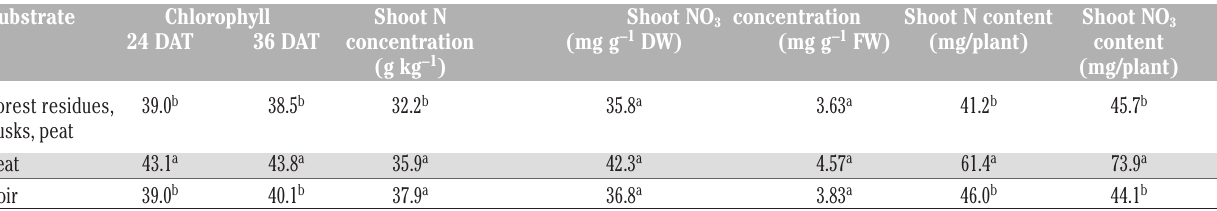
Table 4. Effect of three commercial substrates on leaf chlorophyll (SPAD meter readings) and shoot nitrogen (N) and nitrate (NO centration and content in spinach.